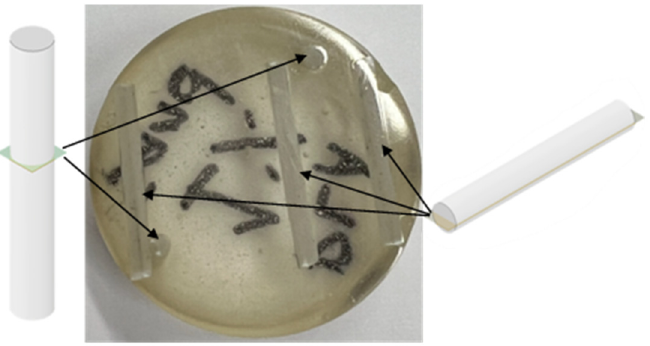
Figure 5. Polished samples for microscopy tests, showing the polished side of longitudinal and vertically aligned samples.